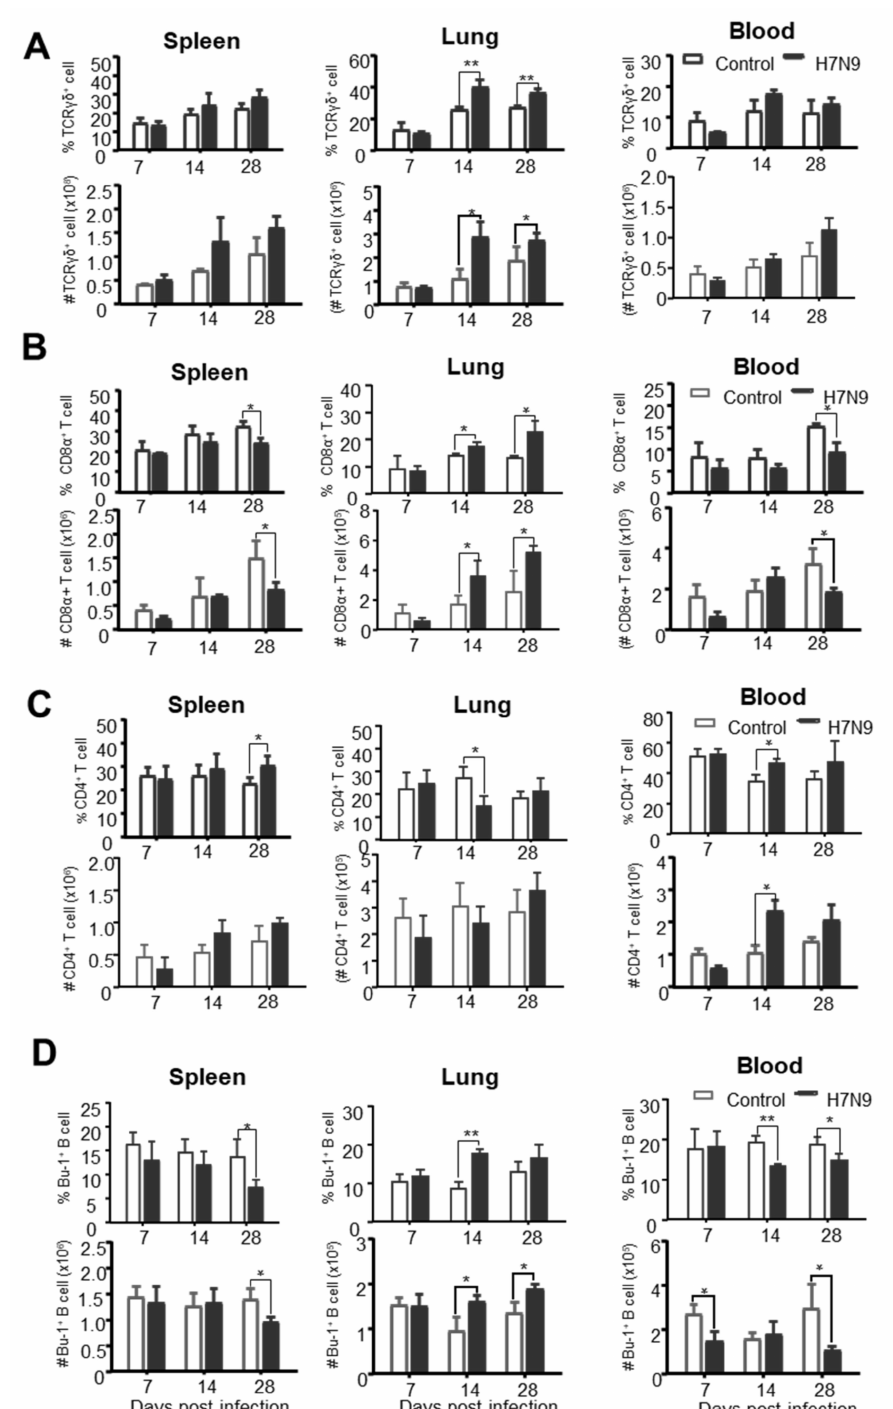
Figure 5. The dynamic changes of chicken’s adaptive immune cells after H7N9 infection. Single cells were isolated from the spleen, lung, and blood of non-infected (Control) and H7N9-infected (H7N9) chickens at 7, 14, and 28 dpi and stained with antibodies from panel 1 or panel 2. Each subset of immune cells was analyzed by flow cytometry. The percentages and total numbers of γδ T cells ( A ), CD8 α + T cells ( B ), CD4 + T cells ( C ), and Bu-1 + B cells ( D ) in spleen, lung, and blood were compared between the two groups. The total number of indicated cells per organ or 5 mL blood was calculated. The values were representative of six di ff erent birds for each group. The mean ± SD value are shown (* p < 0.05, ** p <